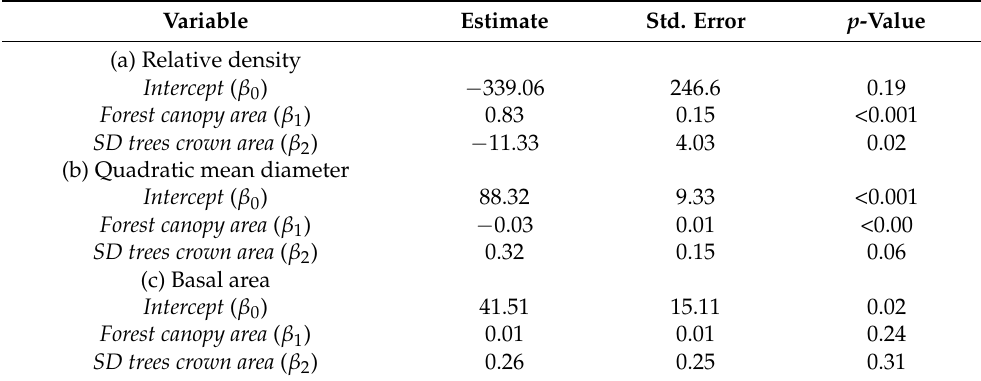
Figure 6. Relationships between quadratic mean diameter (QMD, cm) and density (trees ha − 1 ) versus percentage of detected trees and unmanned aerial vehicle imagery estimated basal area (BA, m 2 ). N = 14 plots. Table 2. Linear model of (a) tree density, (b) quadratic mean diameter, and (c) basal area, related with forest canopy area and standard deviation (SD) of trees’ crown